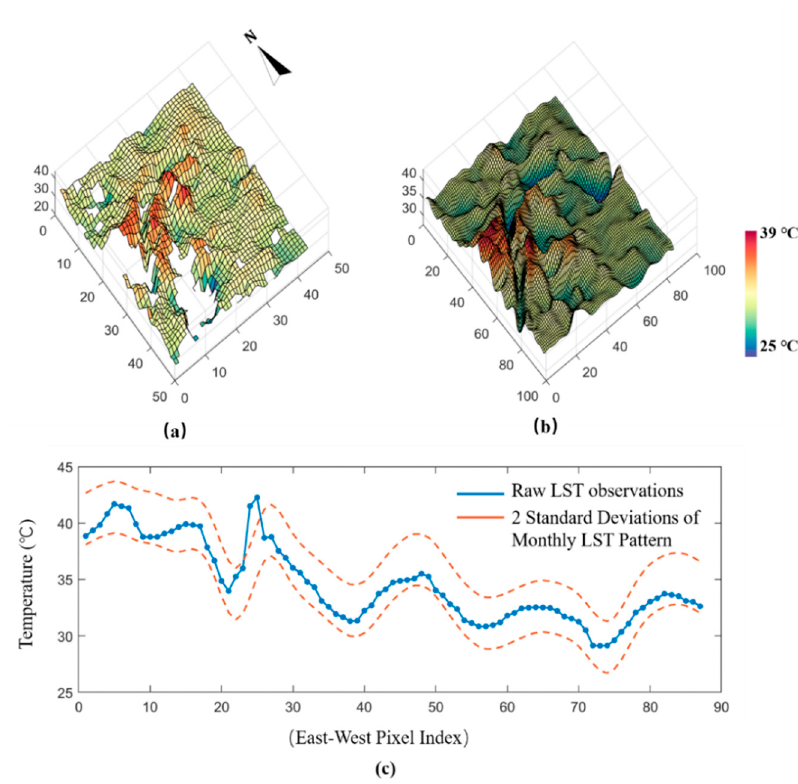
Figure 5. ( a ) The raw MODIS land surface temperature (LST) product of 4 July 2002. ( b ) The corresponding monthly LST pattern extracted by Multi-Task Gaussian Process (MTGP) model. ( c ) Accuracy assessment of extracted monthly LST pattern.